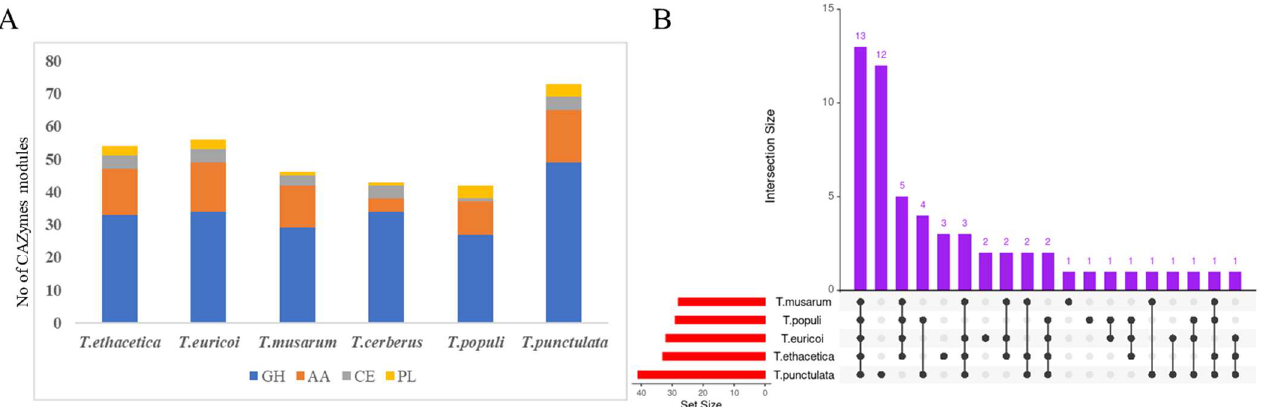
Figure 4. Overview of carbohydrate-activating enzymes (CAZymes) in T. punctulata and its closely related species. ( A ) CAZymes modules in T. punctulata and its closely related species. Y axis denotes number different CAZymes modules. ( B ) Number of CAZY families shared between T. punctulata and its closely related species. Purple bar indicates the intersection. Red bar indicates the data size. Dots and lines connect the species with shared orthologues.